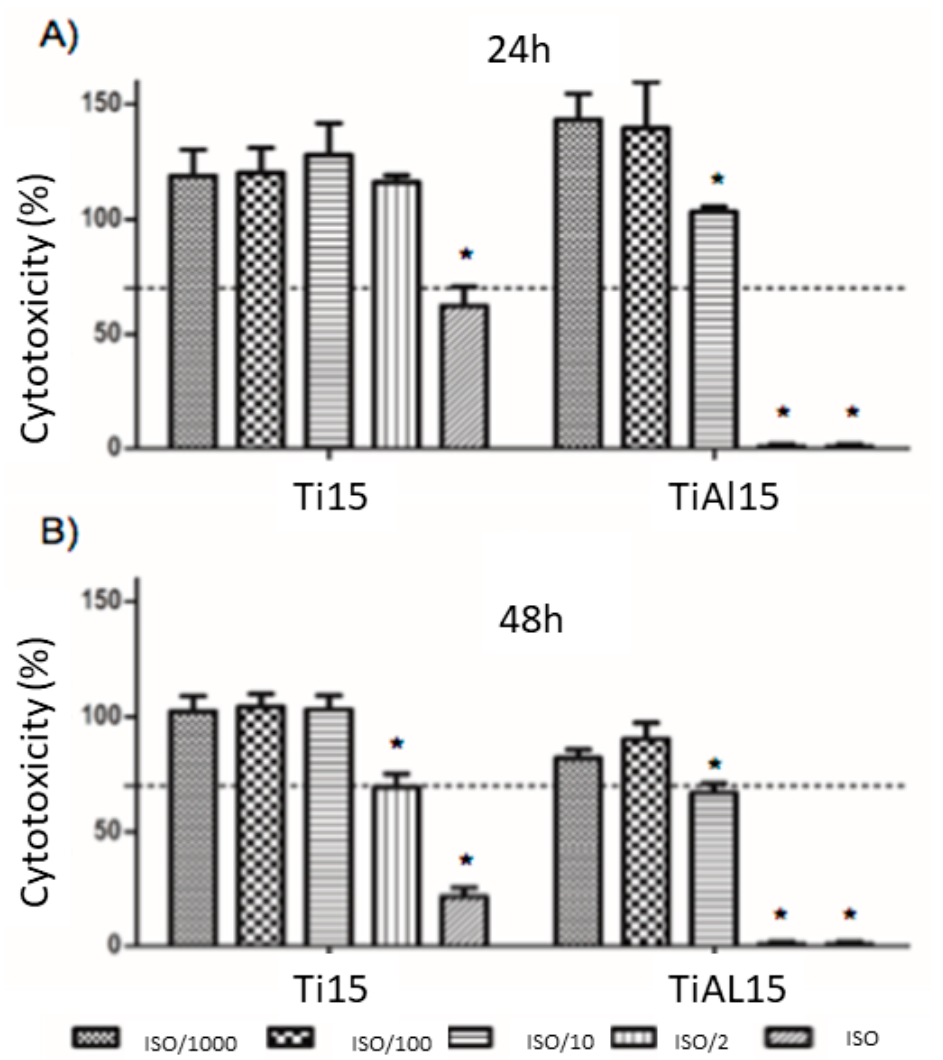
Figure 8. Cytotoxicity levels of THP–1 cells in extracts of microparticles of Titanium. (Ti15) and the alloy of titanium, aluminium and vanadium Ti6Al4V (TiAL15), carried out at 24 h ( A ) and 48 h ( B ). * p < 0.05 vs. its [ISO]/1000.